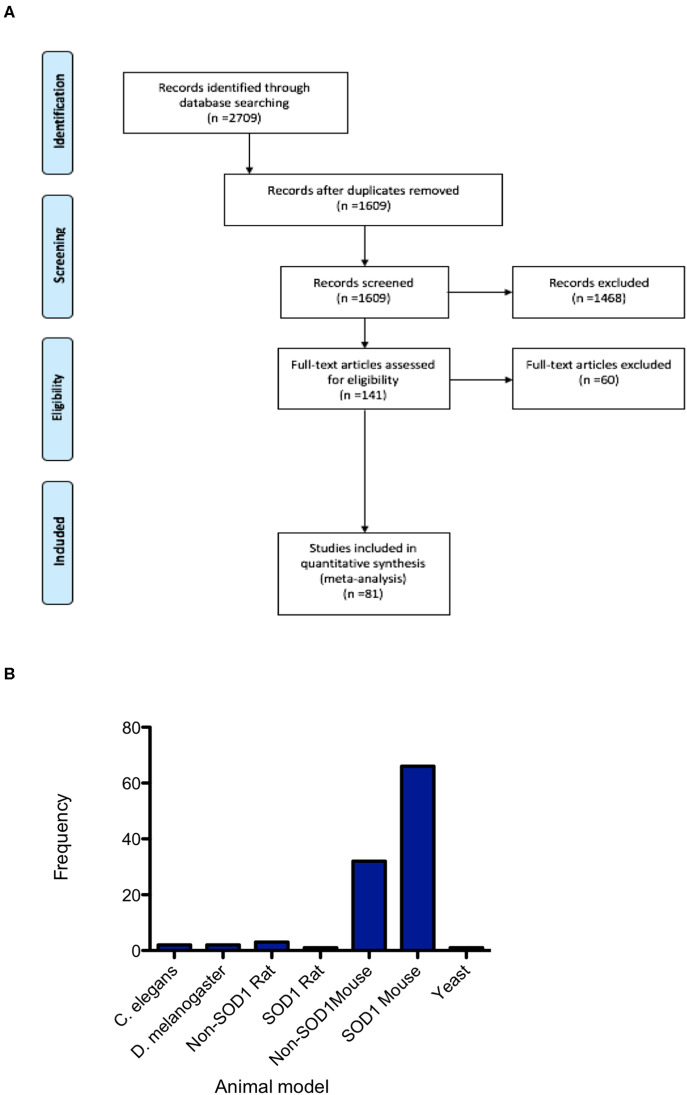
PRISMA flowchart. (A) PRISMA Flow Diagram The PRISMA Group (2009) indicating numbers of studies at each stage of the review. (B) Frequency distribution summarizing the number of studies conducted in each of the animal models, demonstrating the majority of studies are conducted in mice and predominantly in the SOD1 G93A mouse model.